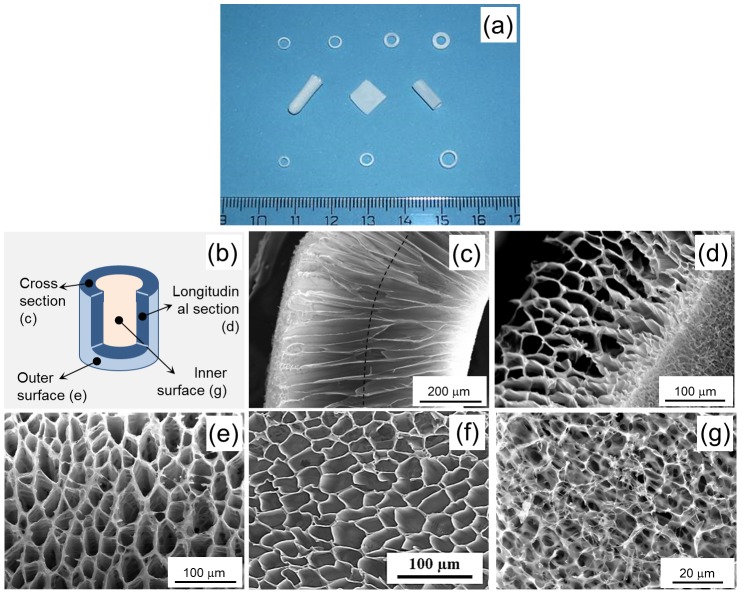
Macro- and micro- morphological features of the foams.(a) gross appearance of the open-end capsular, tubular, flat 3D porous PLCL300 scaffolds (5% w/v, quenched at −80°C) with variable foam thickness and inner lumen diameters; (b) schematic of different sections of the scaffold analyzed under SEM; typical SEM images of (c) cross section of the scaffold showing the lengthwise cut elongated pores in direction of the applied thermal gradient (pore walls and overall channeled character of pores are clearly visible), (d) longitudinal section of the scaffold showing interconnected open-cells between particular channels, and (e) outer surface and (g) inner surface of the scaffold revealing the anisotropic nature of the pores. Panel (f) is the middle section of the foam's cross section (black dotted line in the panel c) showing an internal honey-comb like pore architecture.